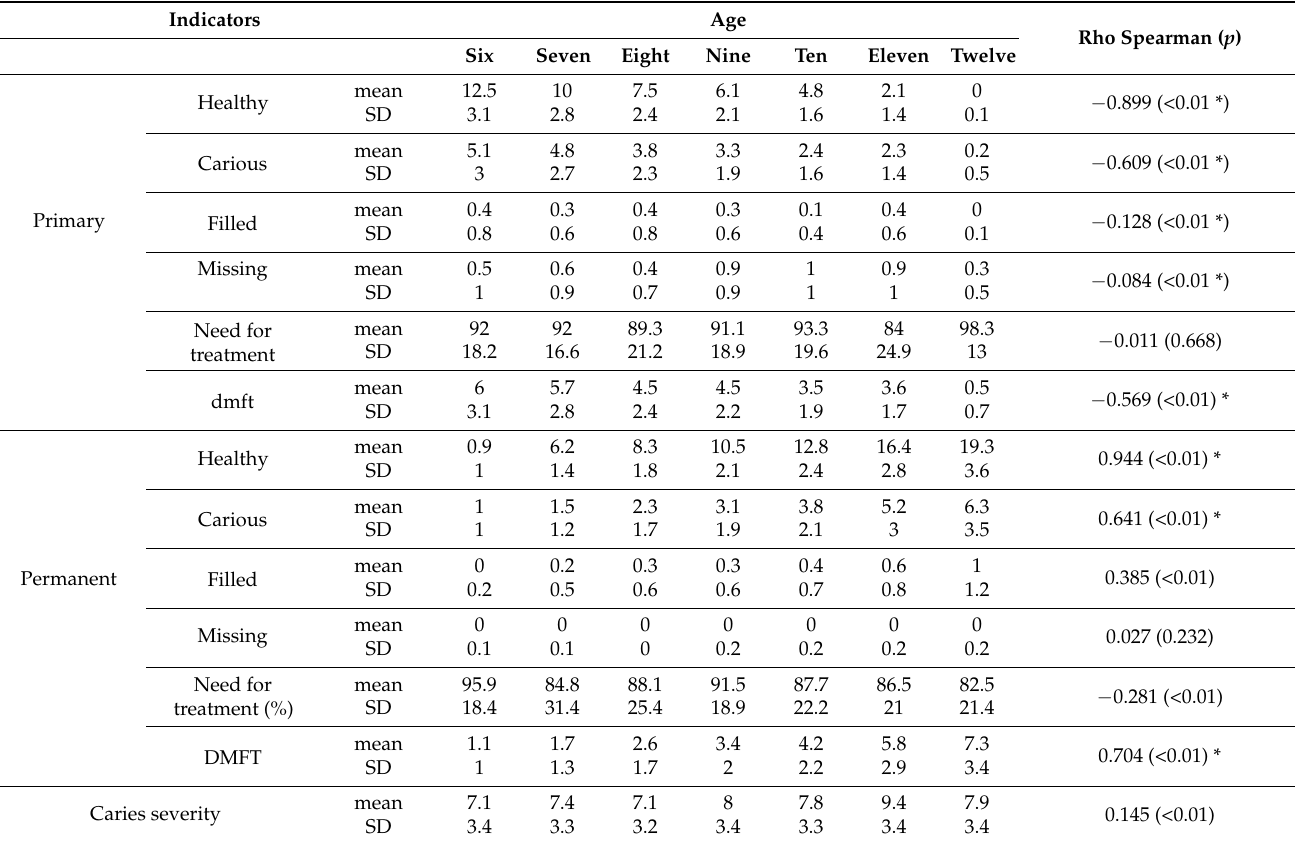
Table 4. dmft/DMFT according to age